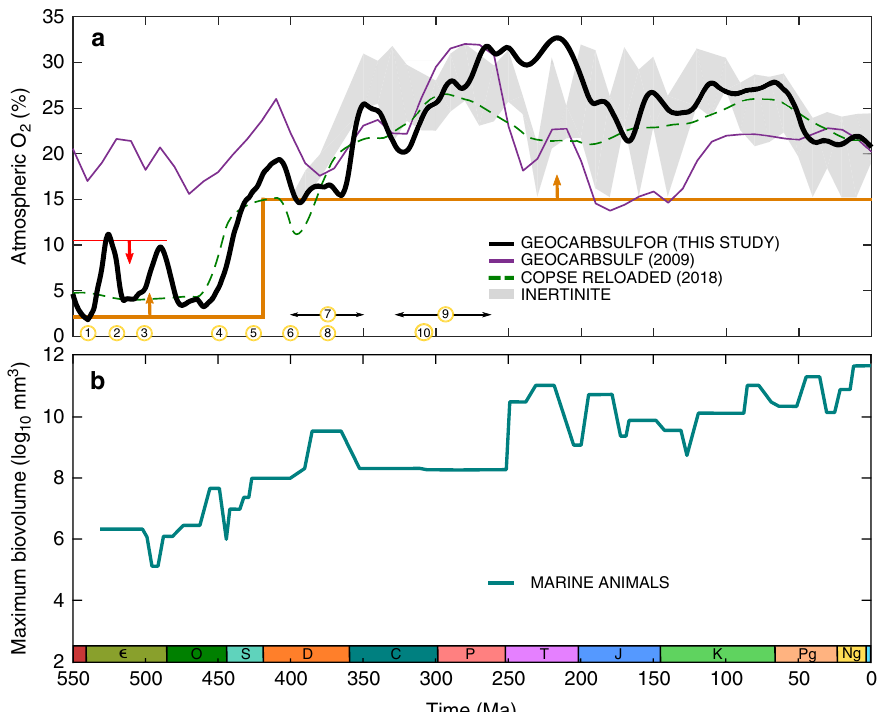
Fig. 3 Results of GEOCARBSULFOR compared to GEOCARBSULF, the COPSE model, and to geochemical proxies. a The black line represents the results from GEOCARBSULFOR, the purple line is the original GEOCARBSULF 21 and the green dashed line is COPSE 22 . The grey envelope shows p O 2 predictions from inertinite data 3 , and the arrowed lines show the boundaries from Fig. 1. The numbered circles denote: (1) the beginning of the Cambrian explosion and a decrease in cerium anomaly values, (2) bioturbation intensi fi cation, (3) the Steptoean positive carbon isotope excursion event, (4) the Great Ordovician Biodiversity Event and evidence of the fi rst land plant spores, (5) earliest evidence for vascular land plants, (6) initial evidence for a rise in δ 98 Mo and I/Ca and a decrease in cerium anomaly values, (7) a reduction in abundance of fossilized charcoal, (8) the fi rst forests, (9) widespread mires and (10) a collapse in coal forests, and a rise to dominance of tree ferns 4,15,50,51,53,55,56,61 . b Marine animal body size 54 evolution over the Phanerozoic. Є Cambrian, O Ordovician, S Silurian, D Devonian, C Carboniferous, P Permian, T Triassic, J Jurassic, K Cretaceous, Pg Paleogene, Ng